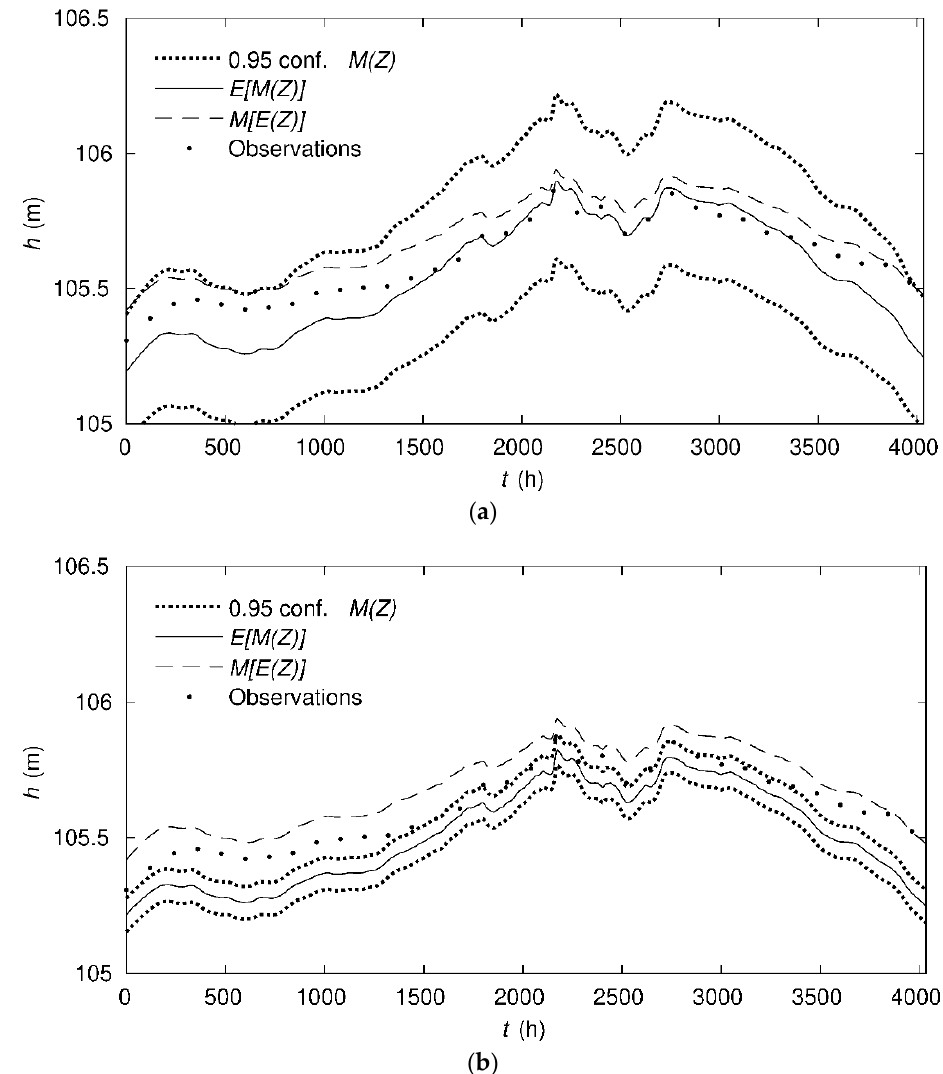
Figure 3. Computed water levels with and without uncertainty during a freshet for the cross-section next to the measurement point. The E [ M ( θ )] stands for the expected output of the probabilistic model enclosed by 0.95 confidence intervals, M [ E ( θ )] is for the deterministic model, and dots for observations; ( a ) for the correlated DTM uncertainty; ( b ) for uncorrelated.